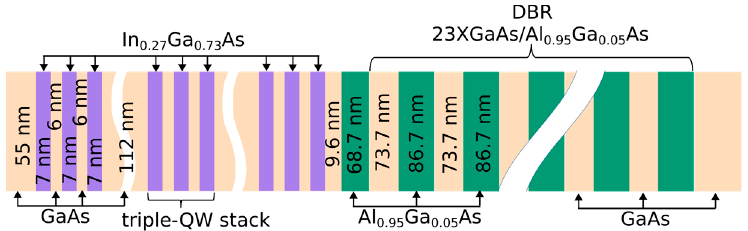
Figure 1. Schematic diagram of the sample structure. The beige-colored areas denote GaAs layers. The violet areas denote In 0.27 Ga 0.73 As layers while the green areas denote Al 0.95 Ga 0.05 As layers. Optical pulses are incident from the left. Table 1. Parameters of lasers.